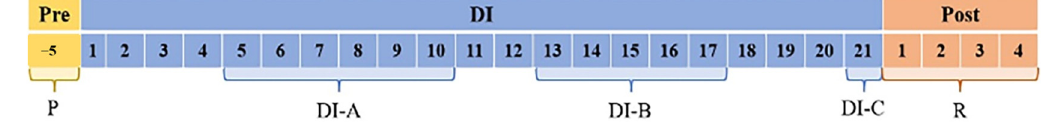
Figure 5. Amortization ratio for rectus femoris muscle (RF): ( A ) close proximal propagation (P1) and ( B ) close distal propagation (D1). The statistical significance of results is noted with an asterisk (*): * p < 0.05. For the P2 accelerometer (RF_AP2) shown in Figure 6A, the increase of the AR was more consistent. Compared to the values collected before DI, (P = 0.082 ± 0.04), after all DI moments, the values increased significantly ( p < 0.05): DI-A = 0.138 ± 0.047, DI-B = 0.166 ± 0.05, and DI-C = 0.162 ± 0.07. For the D2 (Figure 6B) accelerometer (RF_AD2), no significant differences were ob- served between the AR values in relation to the duration of DI ( p > 0.05). Even though the highest AR was observed for the DIB, the differences were not significant ( p > 0.05)